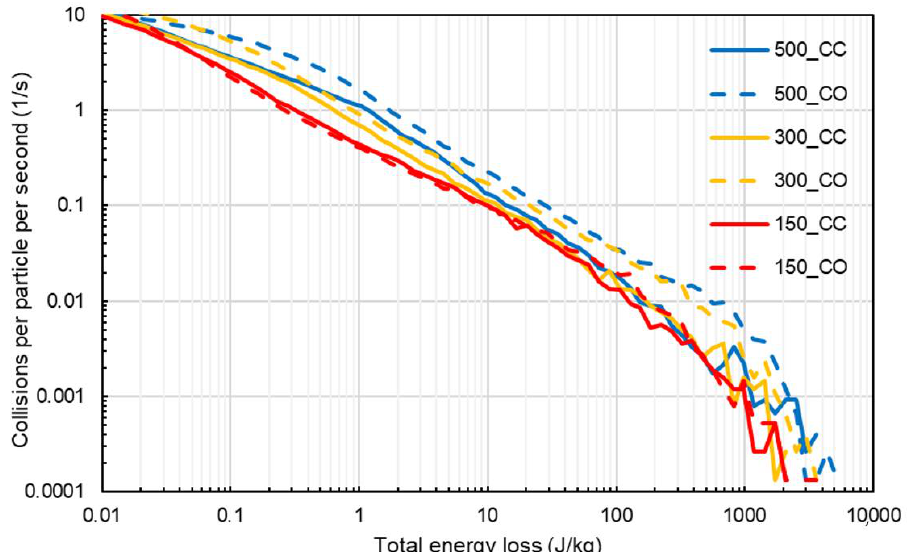
Figure 8. High-energy part of the collision energy spectra for simulations with different values of the impeller speed (in rpm), for counter-current (CC—solid lines) and co-current (CO—dashed lines) configuration, for simulations without cohesion (no-slip Hertz–Mindlin).